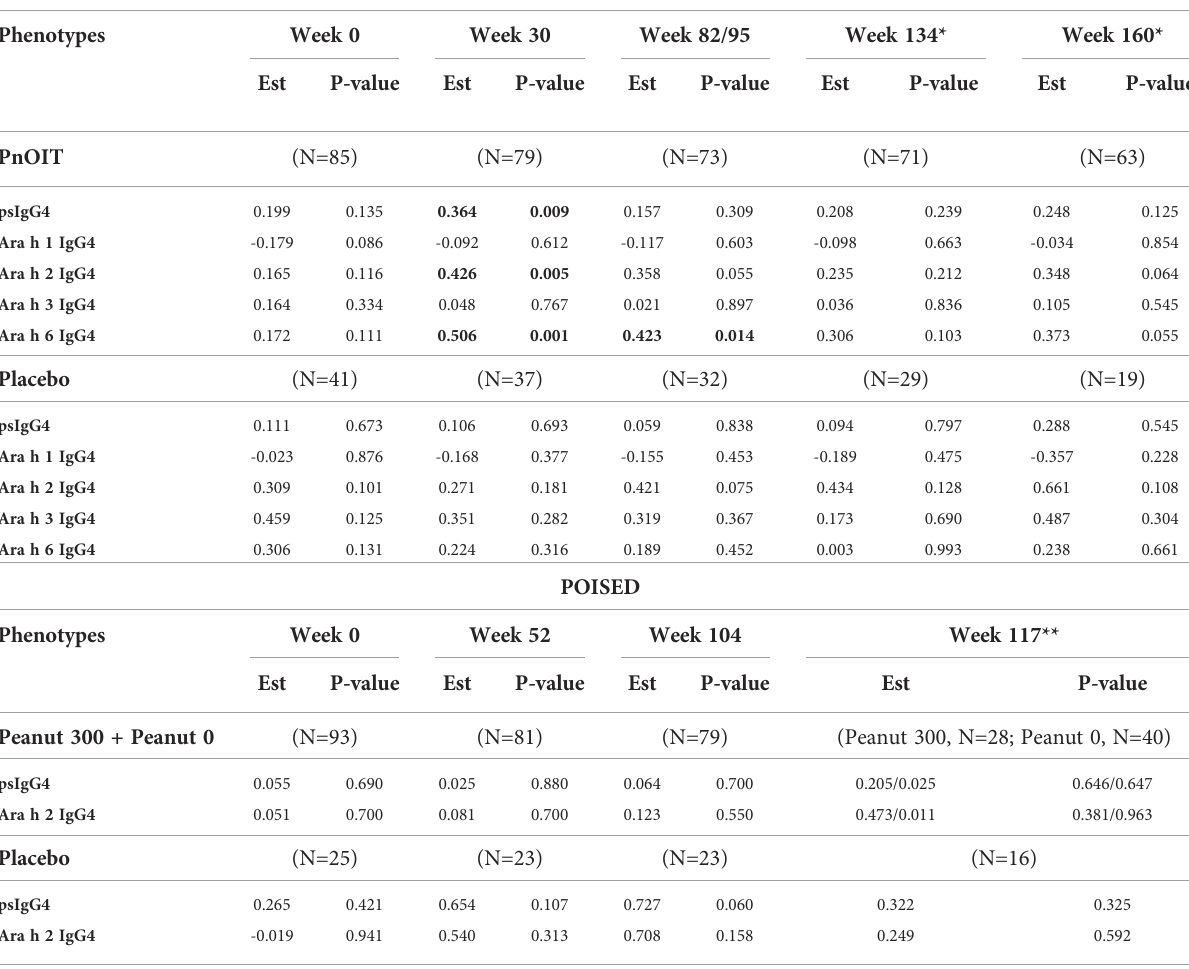
TABLE 2 Association between HLA-DQA1*01:02 and IgG4 in IMPACT and POISED. Table shows the effect size for the log transformed phenotype (Est) and p-values from the linear regression models, and results with p<0.05 are